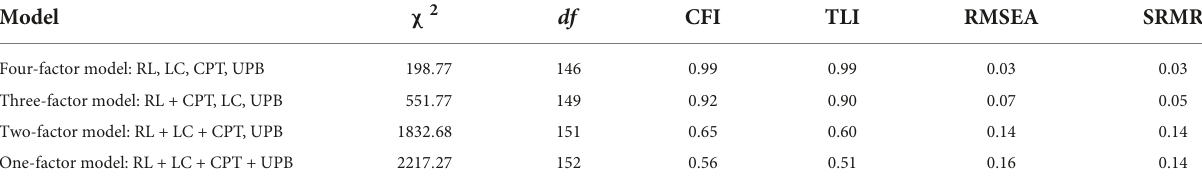
TABLE 1 The confirmatory factor analysis results.